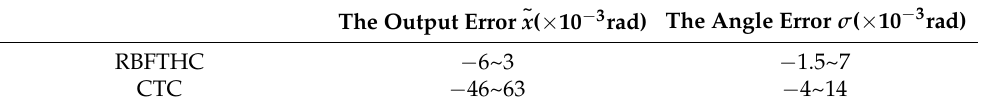
Figure 19. The joint angular velocity Table 4. The simulation 2 results.